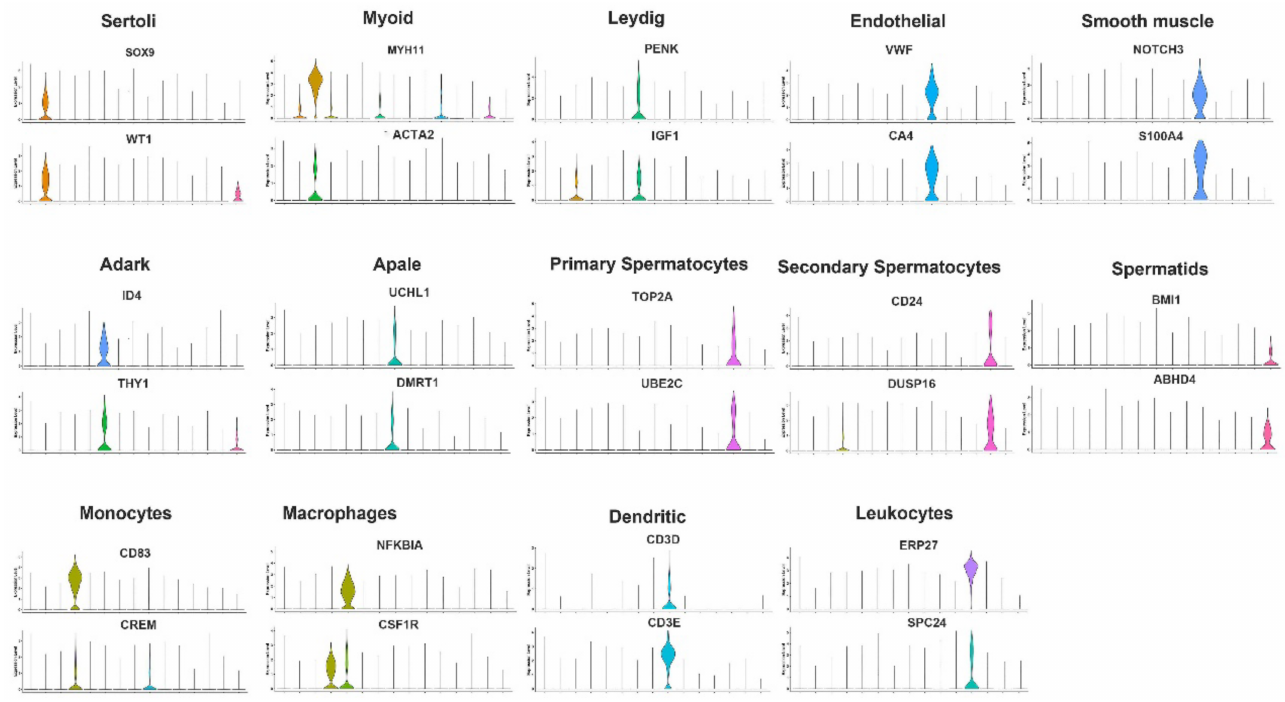
Figure 2. Marker gene identification of each testicular cell type. Expression patterns (violin plot) of each cell-specific gene across the different